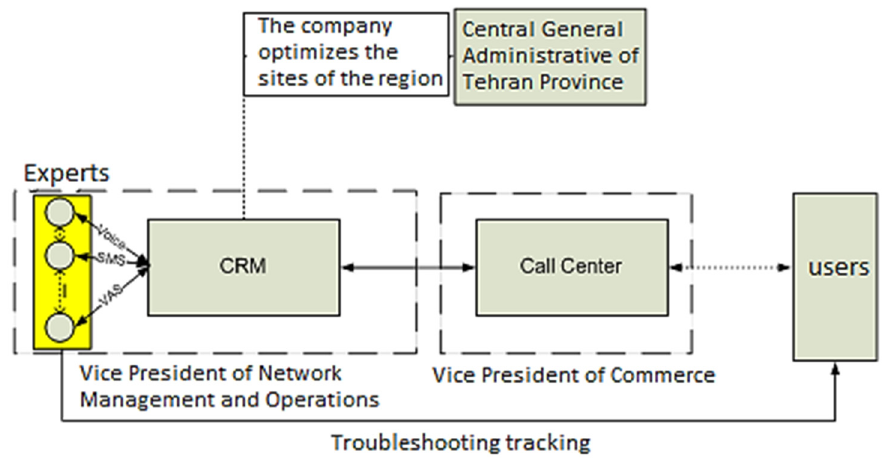
Figure 17. Silhouette coefficient on idle mode scenario with 3 clusters.